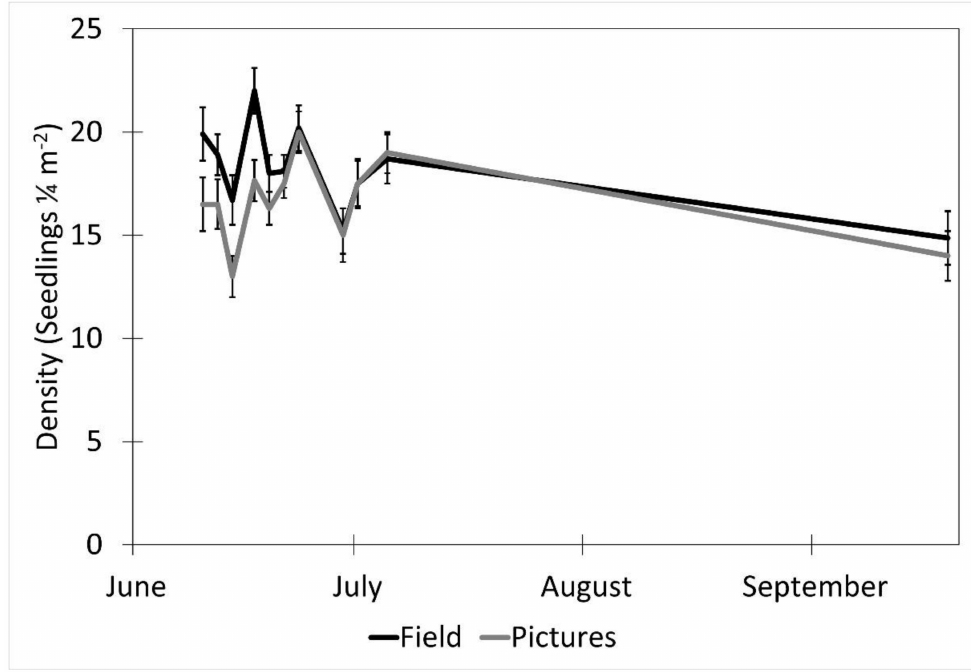
Figure 8. The effect of date on picture density estimates (mean ± SE) from an image and measured in the field over the period of the study. Data were recorded in the field every 2–3 days between 10 June and 5 July 2017, with a final sample collected on 19 September 2017 at the Utah Testing Range,